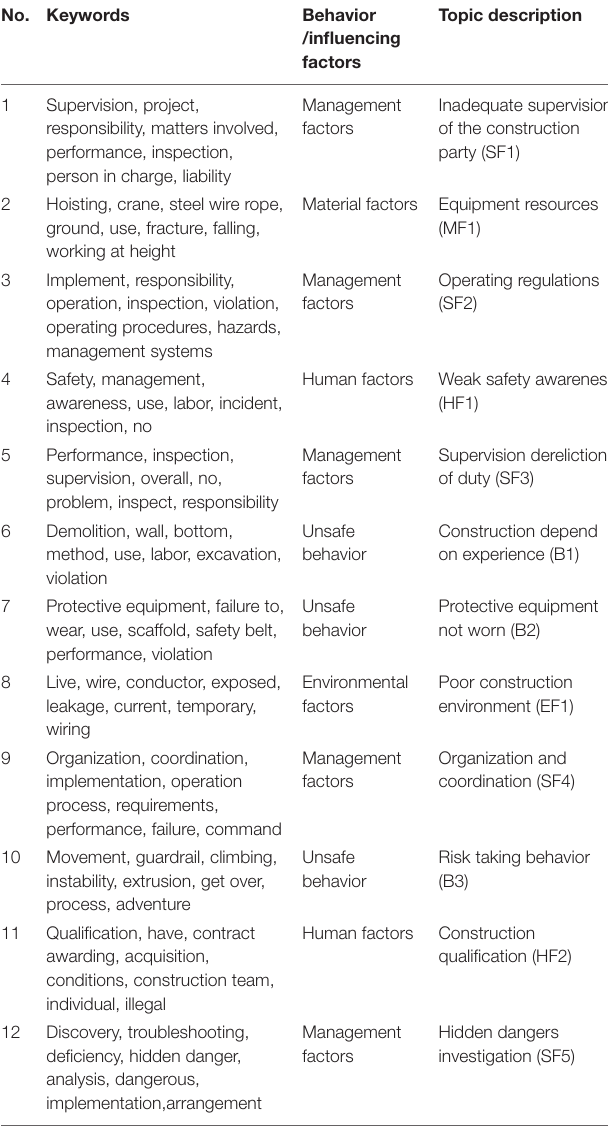
TABLE 2 | Statistics of the number of texts in each district of Shenzhen from 2017 to 2021. No.